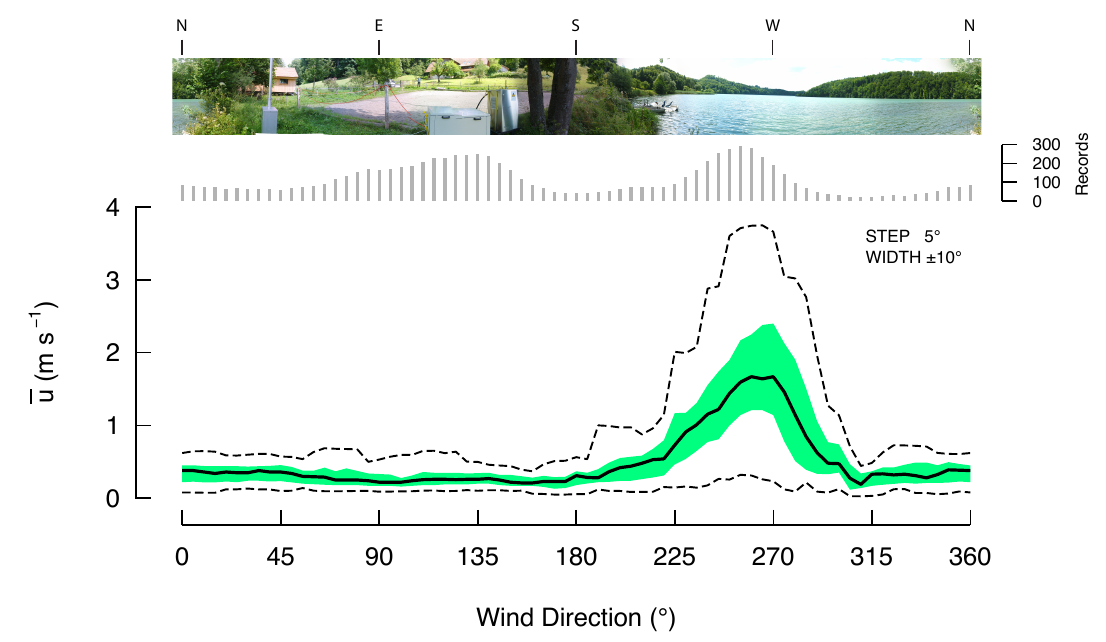
Fig. 2. Horizontal wind speed as a function of wind direction. For reference, a panorama image taken at the position of the sonic anemometer sensor head is shown in the top section. Data were aggregated for overlapping wind direction sectors of 10 ◦ with 50% overlap. Median (bold line), interquartile range (shaded area; 50% of all values), and maximum and minimum values (dashed lines) are shown. The predominent wind direction from the west is also reflected by highest wind speeds. The inset below the panorama image shows the number of records available for each wind direction